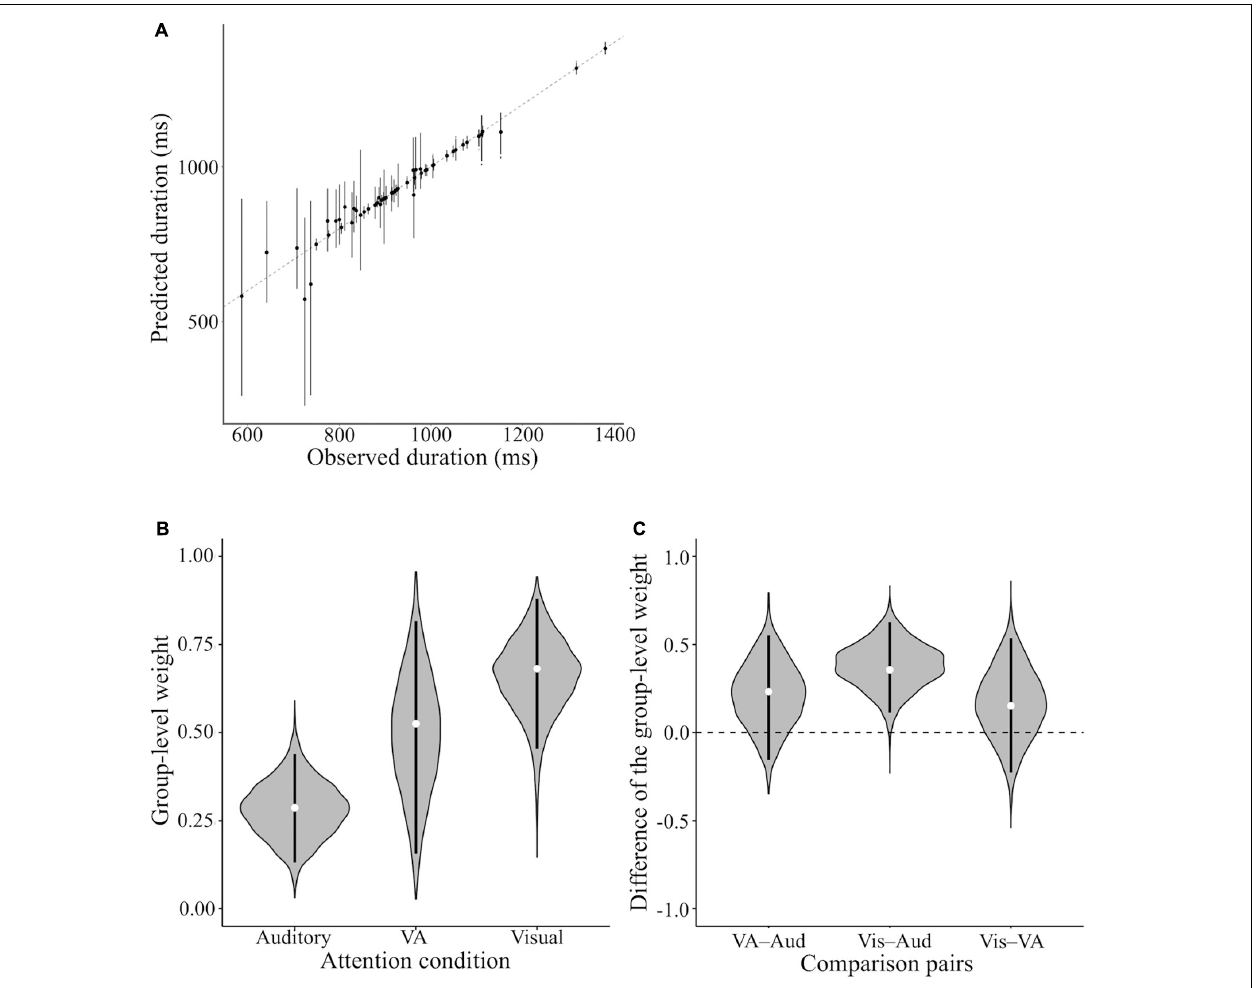
FIGURE 9 | Results of the model assuming the weight by attention and reliability. (A) The actual and predicted PSE. The black dot indicates the mode of the simulation in each subject and condition. The black line indicates 95% HDI. The dotted line indicates the predicted PSE equal to the actual PSE. (B) The posterior distributions for the group-level weights ( µ a ) in each condition. The white dot indicates the mode of the posterior distribution. The black line indicates 95% HDI. (C) The posterior distributions for the difference of the group-level weights ( µ a ) across attention conditions. The white dot indicates the mode of the posterior distribution. The black line indicates 95% HDI. Vis, Aud, and VA represent visual, auditory, VA attention conditions, respectively. Comparison pairs represent the difference between each attention condition (i.e., Vis–Aud represents the difference between visual and auditory attention